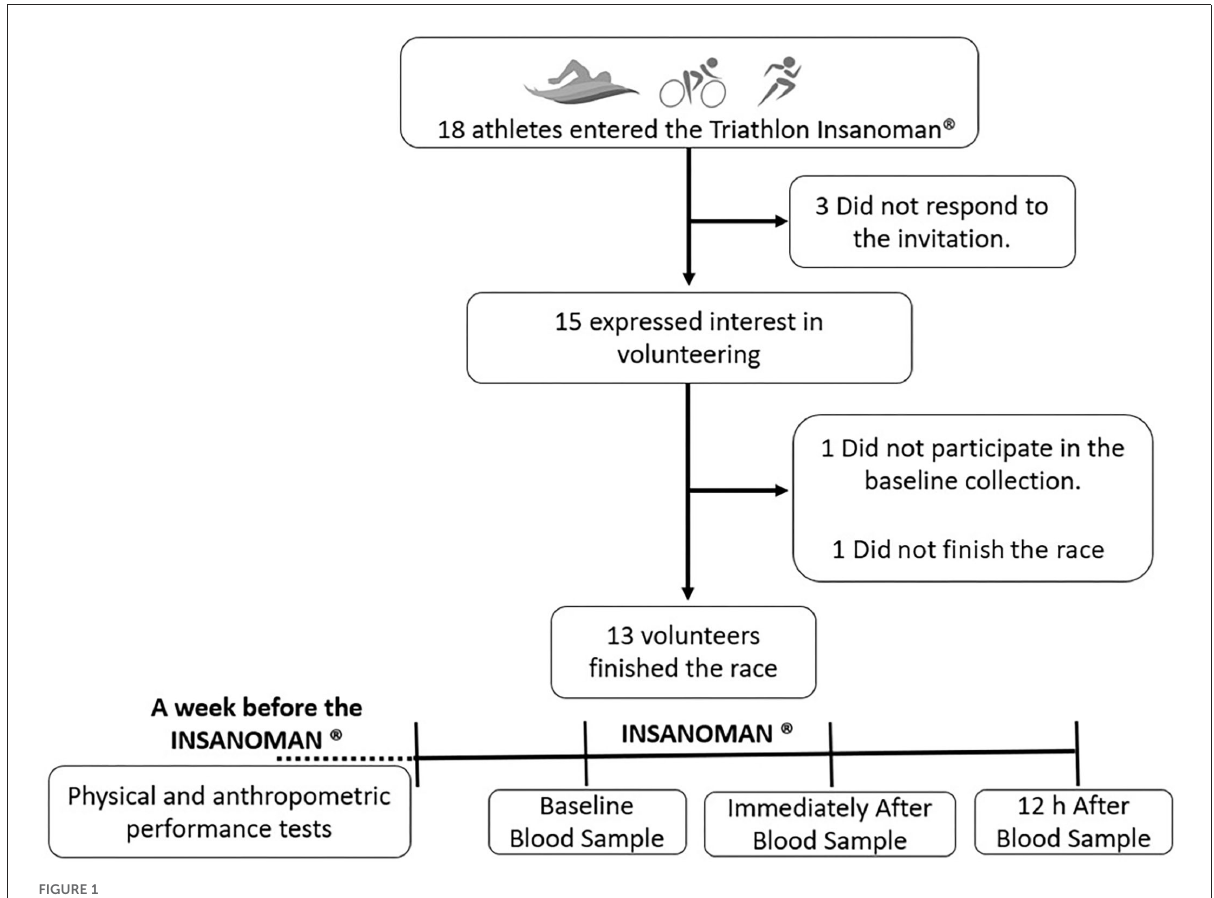
FIGURE1 Flow diagram and experimental design of the